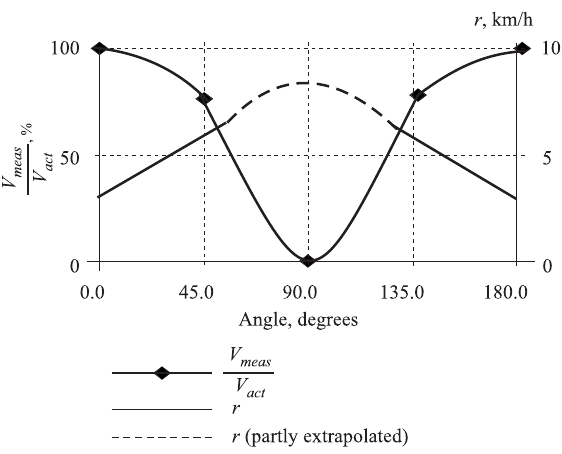
Fig. 4. Accuracy (% of true speed) and precision